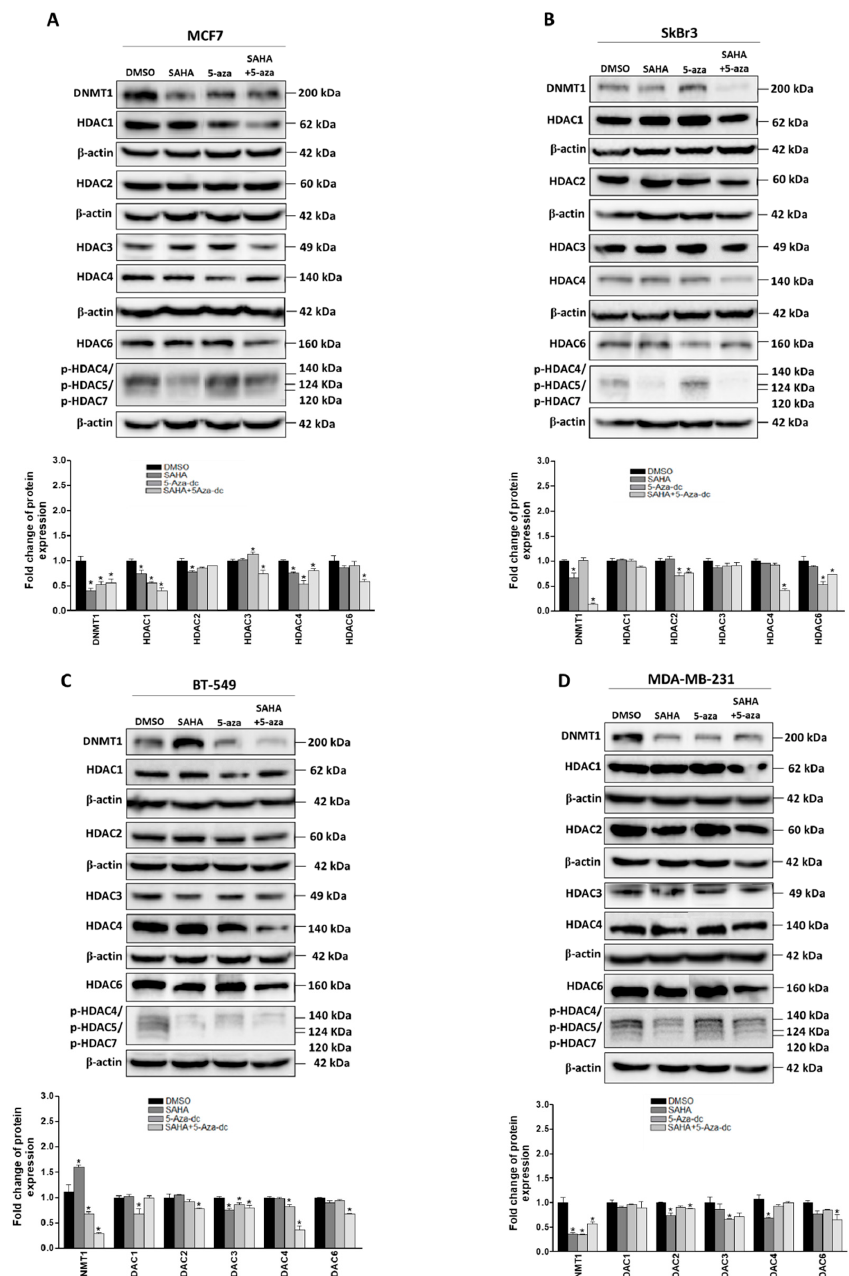
Figure 3. Effect of suberoylanilide hydroxamic acid (SAHA) and 5-aza-dc on the expression of epigenetic markers in breast cancer cells. Analysis of DNMT1, HDAC1, 2, 3, 4, 6, and p-HDAC 4/5/7 proteins upon treatment with IC50 concentrations of SAHA for 72 hours or/and 5-aza-dc for 96 hours in ( A ) MCF7, ( B ) SkBr3, ( C ) BT-549, and ( D ) MDA-MB-231. DNMT1 and HDAC1 were visualized on the same blot, HDAC2, HDAC6 and phospho- HDAC4,5 and 7 were visualized on another blot whereas HDAC3 and 4 were visualized on a third blot. Bar graphs showing the relative fold change of DNMT1 and HDACs after normalization to β -actin expression and DMSO treatment. The level of each protein was normalized to the corresponding β -actin from the same blot. Shown are the means ± SEM of at least three independent experiments. * p < 0.05 versus DMSO group.